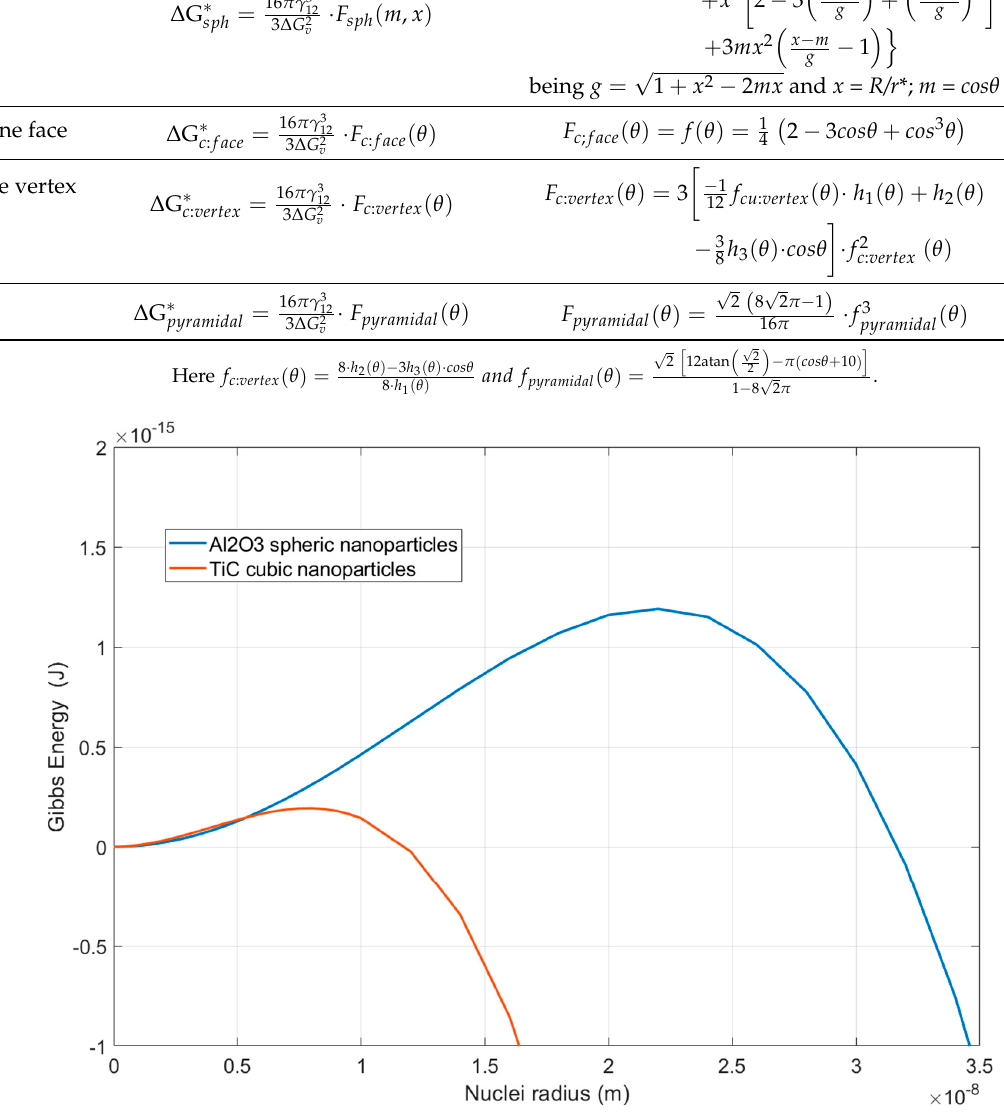
Figure 6. Influence of the introduction of TiC and Al 2 O 3 nanoparticles on the Gibbs energy.